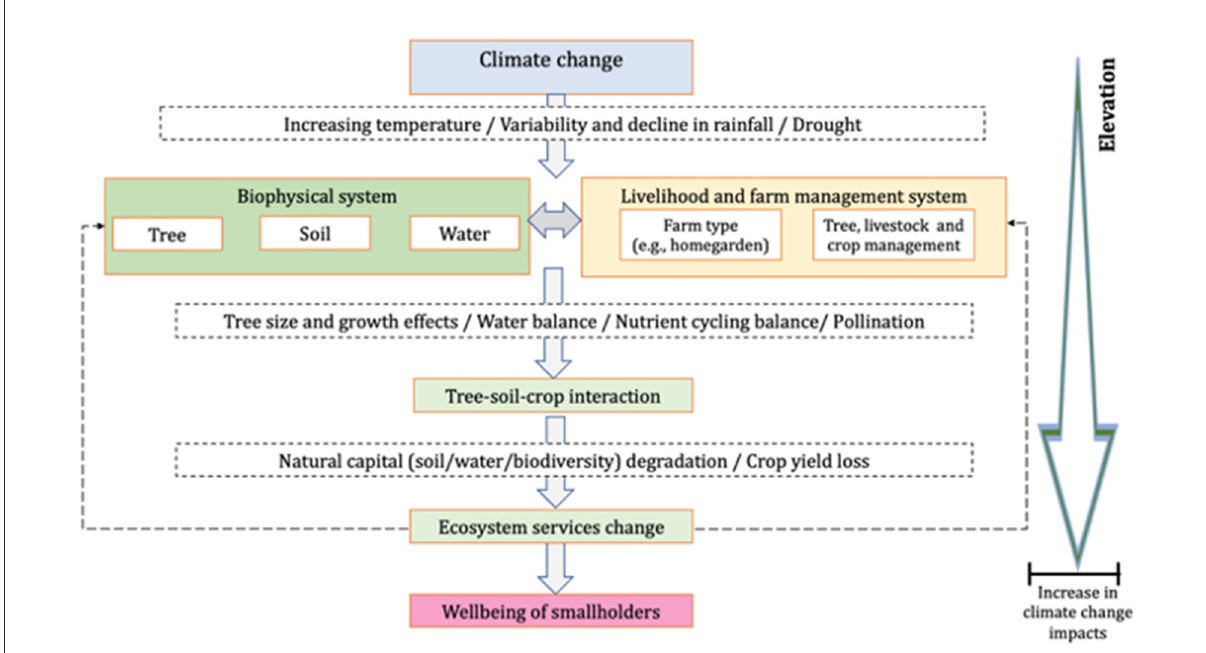
FIGURE6 Conceptual model depicting the components, relationships, and feedbacks under climate change in TAFS and how these change with elevation. This model depicts the main processes (solid boxes) and underlying mechanisms (dashed boxes) affecting the wellbeing of smallholder farmers in TAFS. Solid arrows denote the main causal direction, whilst dashed arrows denote